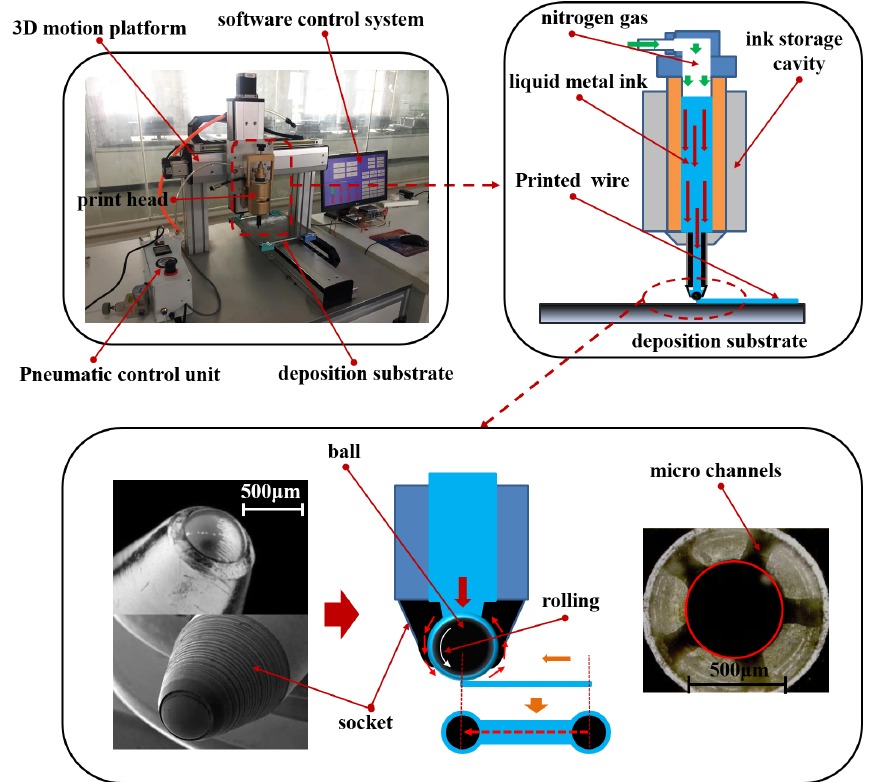
Figure 1. Schematic diagram of the process principle and experimental system.